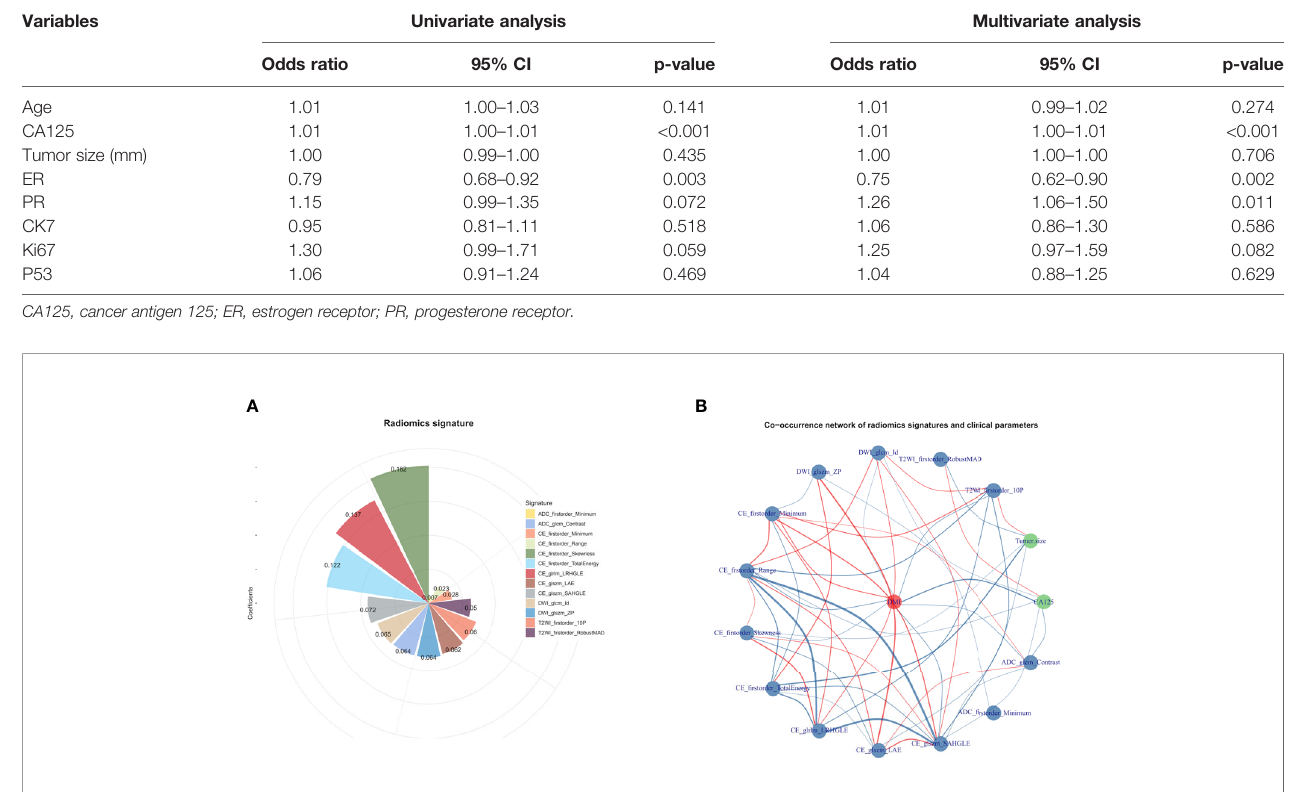
FIGURE 3 | (A) The selected features for DMI in G 1/2-EEC patients for ovarian preservation. The chart shows that the features contribute to the radiomics signature with their coef fi cients obtained from linear regression. (B) The co-occurrence matrix plots the correlations of the patients for DMI (red spot), clinical parameters (CA125 and tumor size), and radiomics features. The blue line indicates a negative correlation, and the red line indicates a positive correlation (p <